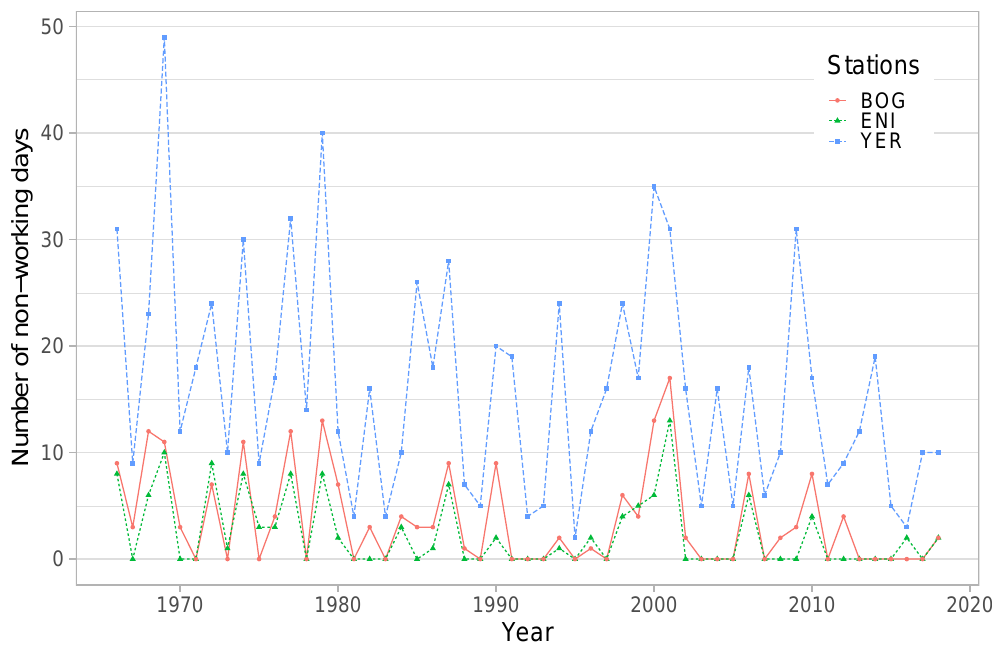
Figure 3. Dynamics of within-year non-working days number for Boguchany (BOG), Yeniseysk (ENI), and Yerbogachen(YER): 1966–2018. Note: for other stations, the average number of non-working days does not significantly differ from